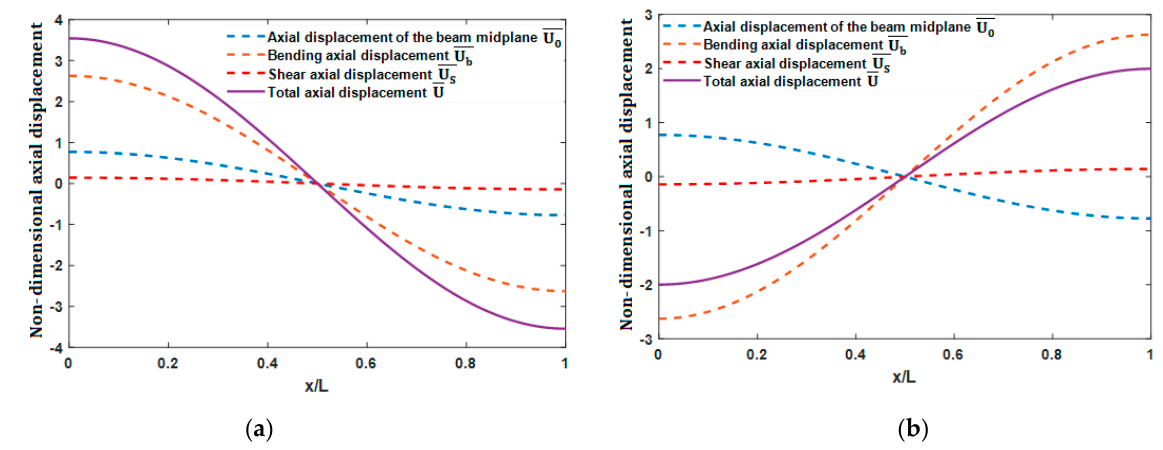
Figure 5. Shear effect on axial displacement a long of the FGB on: ( a ) lower beam face and ( b ) upper beam face.